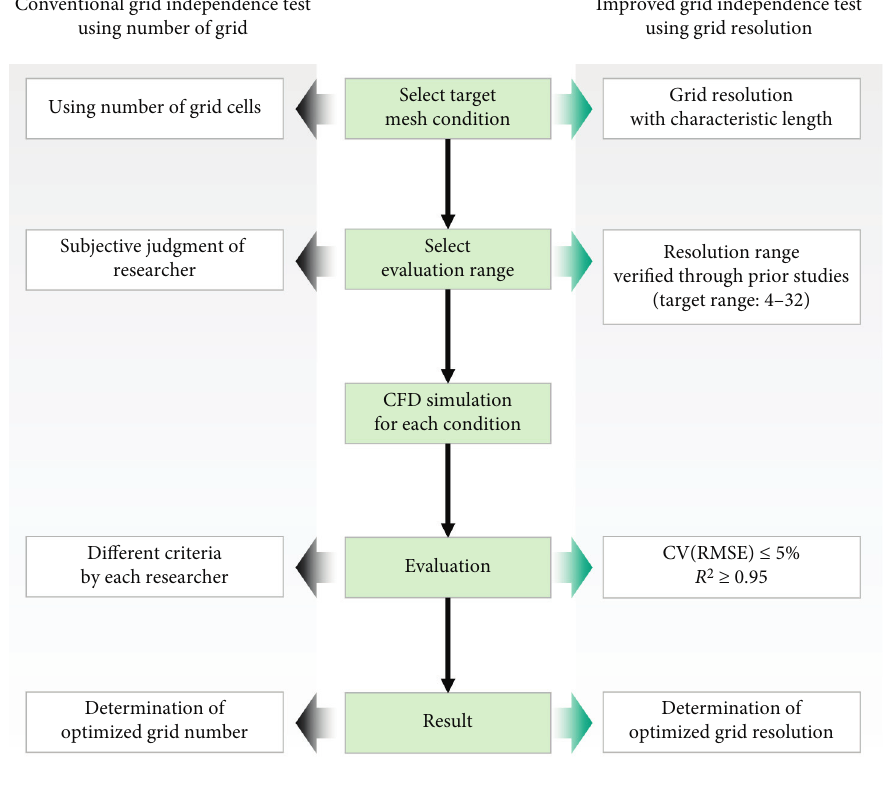
Figure 1: Suggested scheme used to improve grid independence test for the CFD